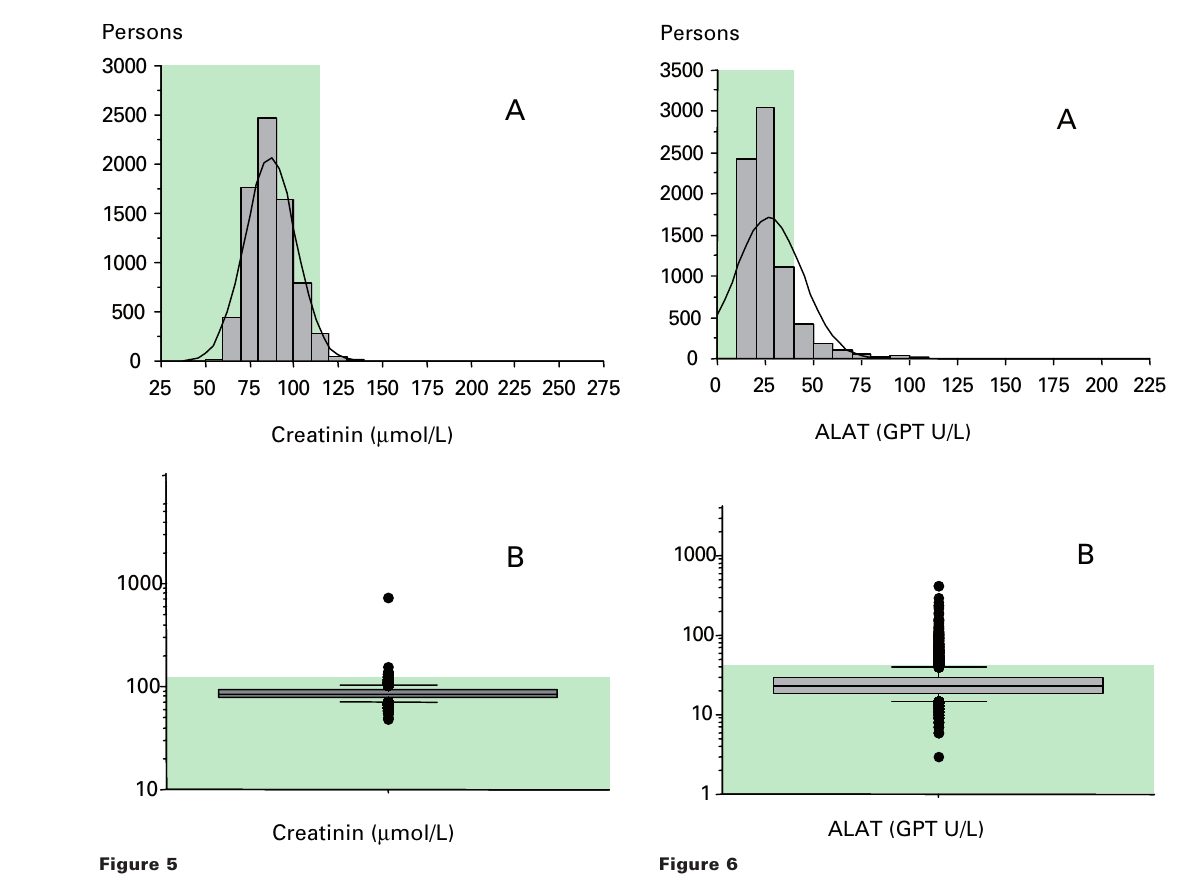
Liver cell destruction – ALAT. In a very high number of draftees liver cell destruction could be suspected on account of their ALAT values (A+B). Accordingly, ALAT values among draftees were not distributed normally (A). In 9 draftees the ALAT was elevated >200 m mol/L (B). The area shaded in green indicates the normal range.